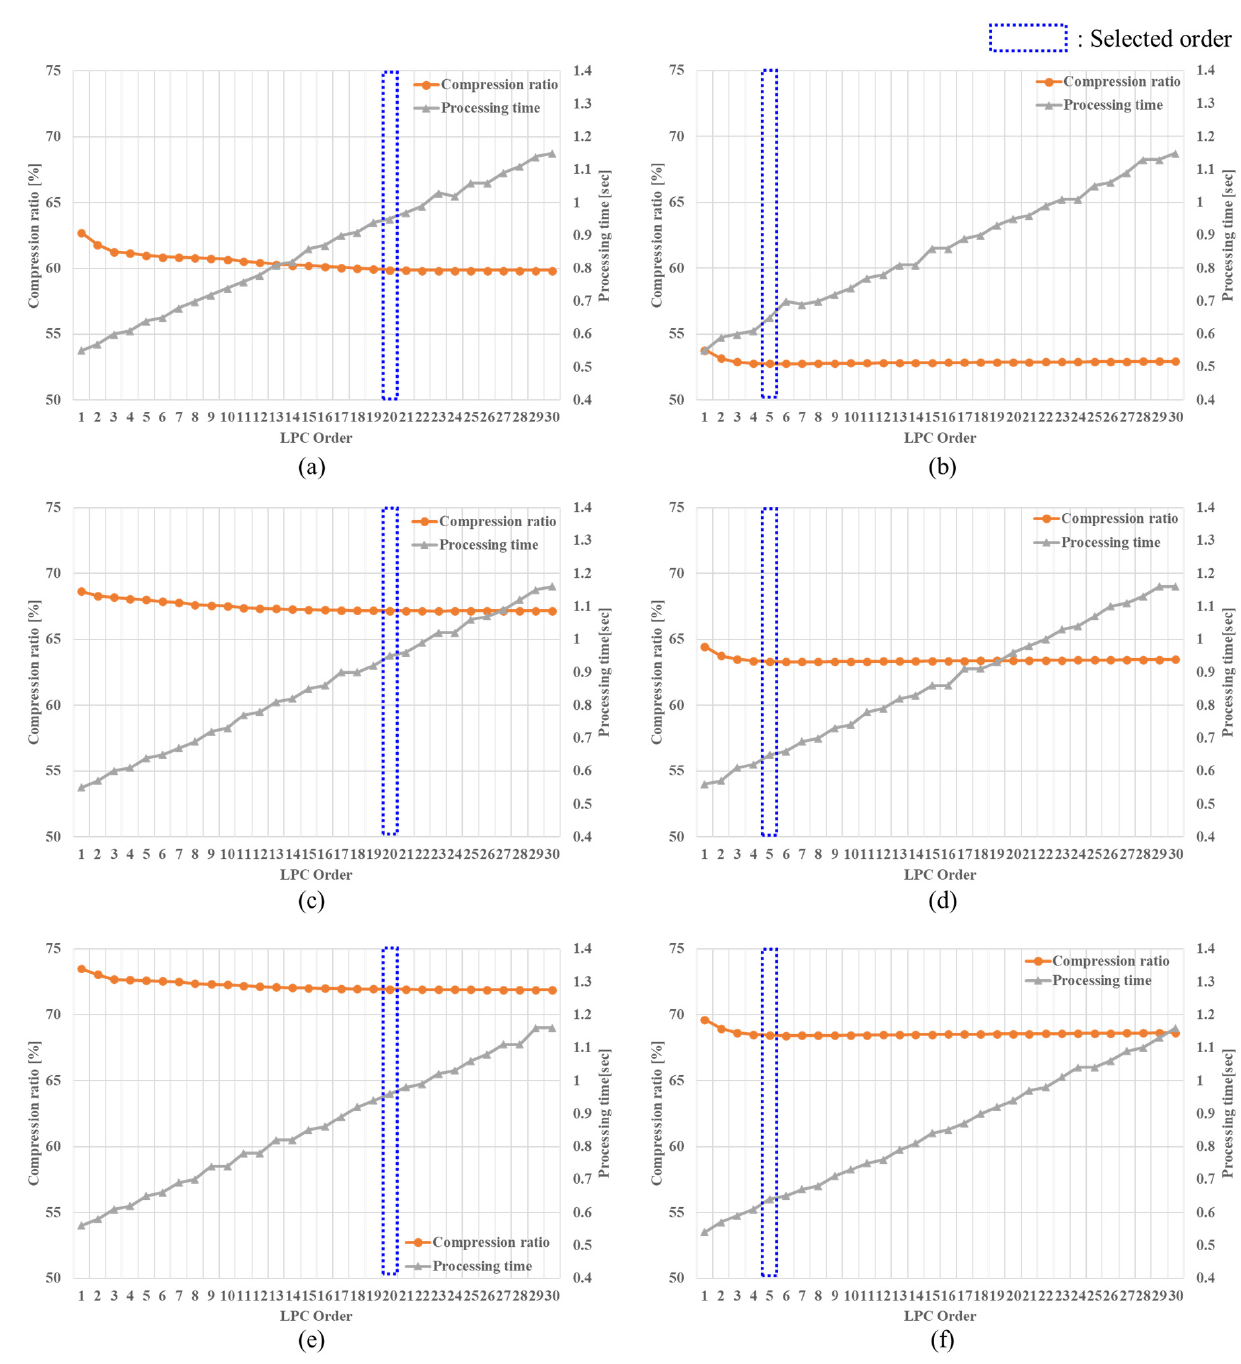
Figure 8. Comparison of the compression ratio and processing time according to different LPC orders: ( a ) sensor #1 (low sub-band), ( b ) sensor #1 (high sub-band), ( c ) sensor #2 (low sub-band), ( d ) sensor #2 (high sub-band), ( e ) sensor #3 (low sub-band), and ( f ) sensor #3 (high sub-band).